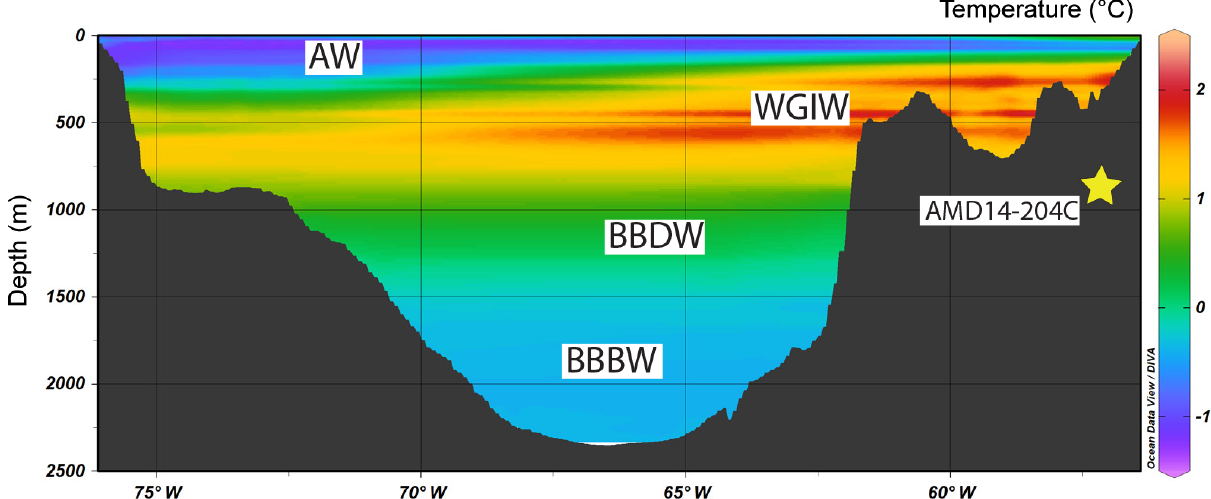
Figure 2. Water temperature transect at 73 ◦ N showing the different water masses. The yellow star indicates the core site at 987m water depth. Abbreviations: AW: Arctic Water (0–300m); WGIW: West Greenland Intermediate Water (300–800m); BBDW: Baffin Bay Deep